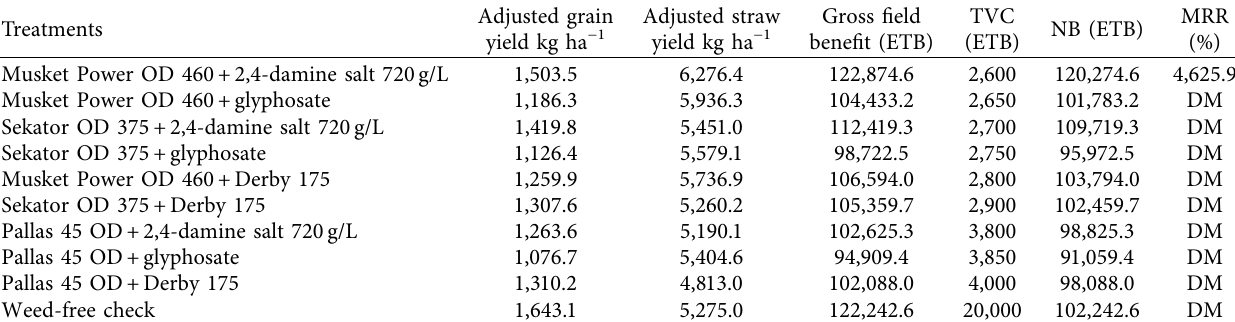
Table 4: Partial budget analysis for combined mean of 2020 and 2021